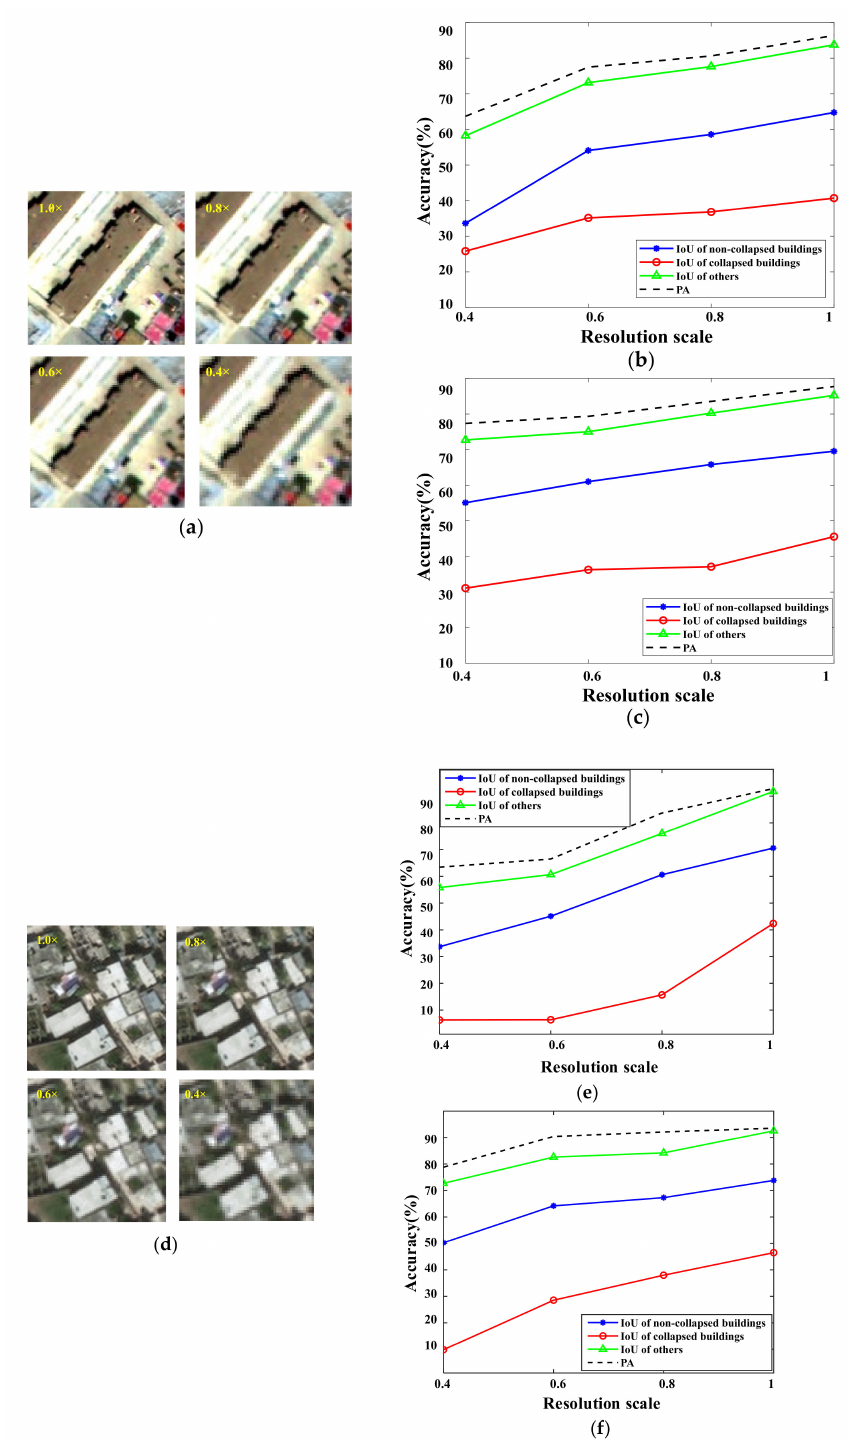
Figure 17. The influence of the spatial resolution of images on the segmentation accuracy: ( a ) down-sampling results of original images at the resolution scales of 0.8, 0.6 and 0.4 based on the YSH dataset; ( b ) IoU and PA curves by OB-DeepLabv3+ for images with different resolutions based on the YSH dataset; ( c ) IoU and PA curves by OB-UNet for images with different resolutions based on the YSH dataset; ( d ) down-sampling results of original images at the resolution scales of 0.8, 0.6 and 0.4 based on the HTI dataset; ( e ) IoU and PA curves by OB-DeepLabv3+ for images with different resolutions based on the HTI dataset; ( f ) IoU and PA curves by OB-UNet for images with different resolutions based on the HTI